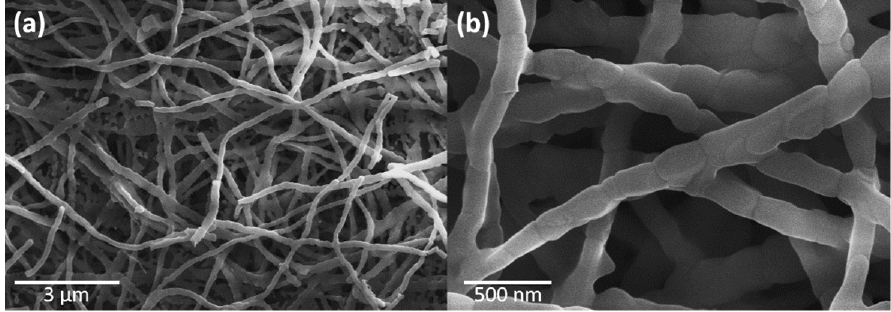
Figure 6. FESEM images of CuYO 2 nanofibers with different magnification ( a ) x10.0 k and ( b ) x50.0 k.